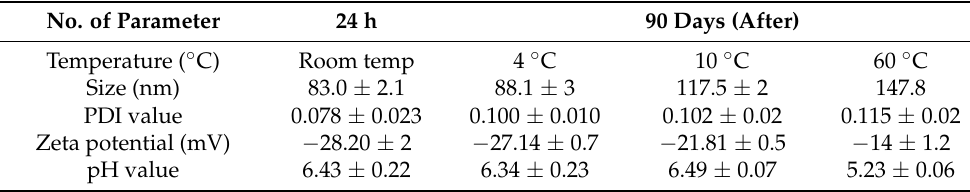
Table 3. Stability analysis of P-NE during 90 days